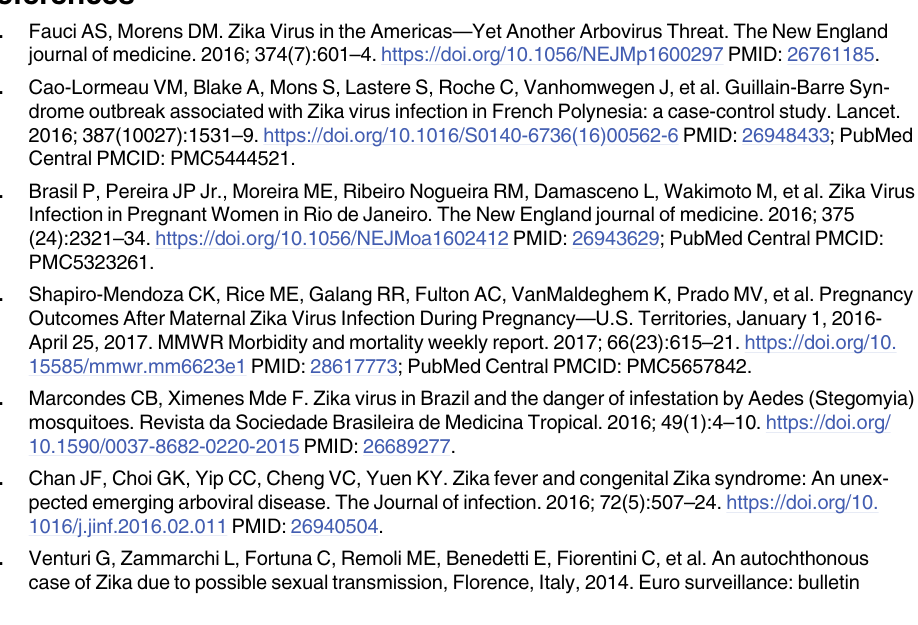
S1 Table. Flavivirus NS1 sequences subcloned into the NdeI/EcoRI sites of the pET-22b vector. S2 Table. Recovery assay of normal human sera spiked with hexameric ZNS1 by 1F5 indi- rect competitive